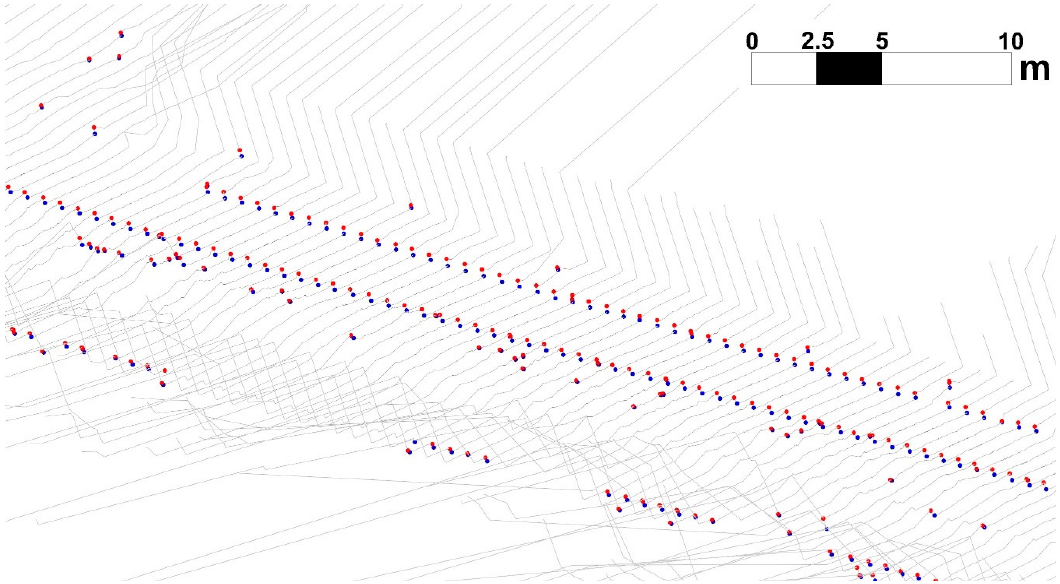
Figure 13. Bottom (blue) and top (red) road curb break lines candidates’ pair of points.